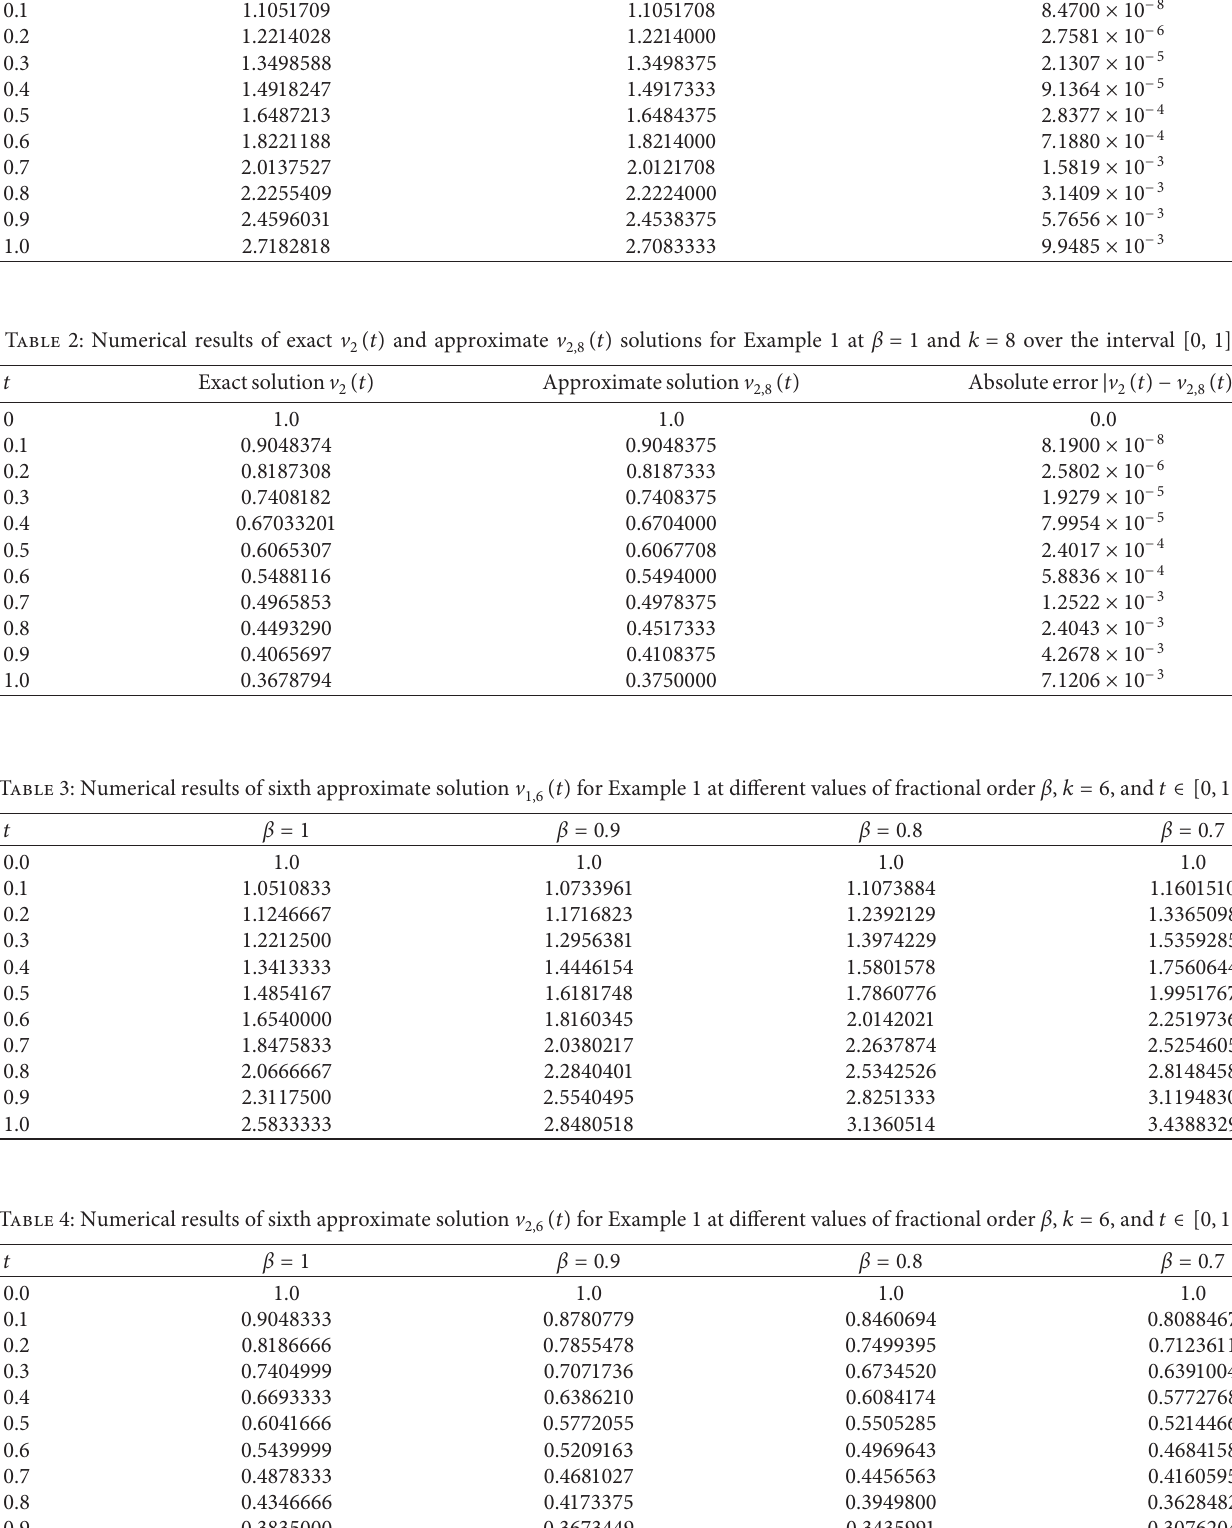
Table 1: Numerical results of exact v